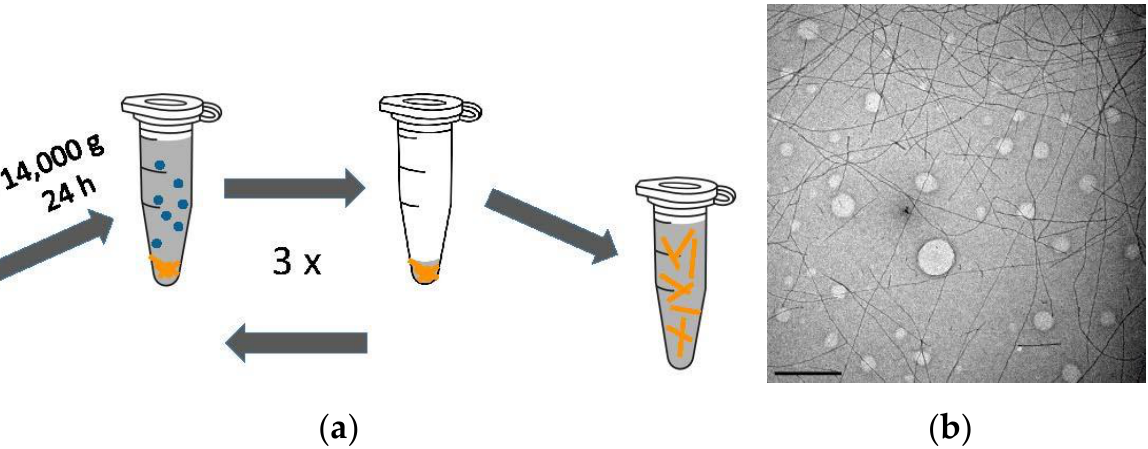
Figure 1. Preparation and Characterization of Isolated hewL Amyloid Fibrils. ( a ) HewL fibrils were pelleted at 14,000 g and 15 °C for 24 h. The supernatant was discarded, and the pellet resuspended in buffer or pH adjusted water. This process was repeated 3× to obtain the isolated fibril stock used in all subsequent experiments. ( b ) TEM image of isolated HEWL fibril stock, diluted to 0.2 µM monomer equivalent. Scale bar: 500 nm. (Light circles are due to defects in TEM grid).